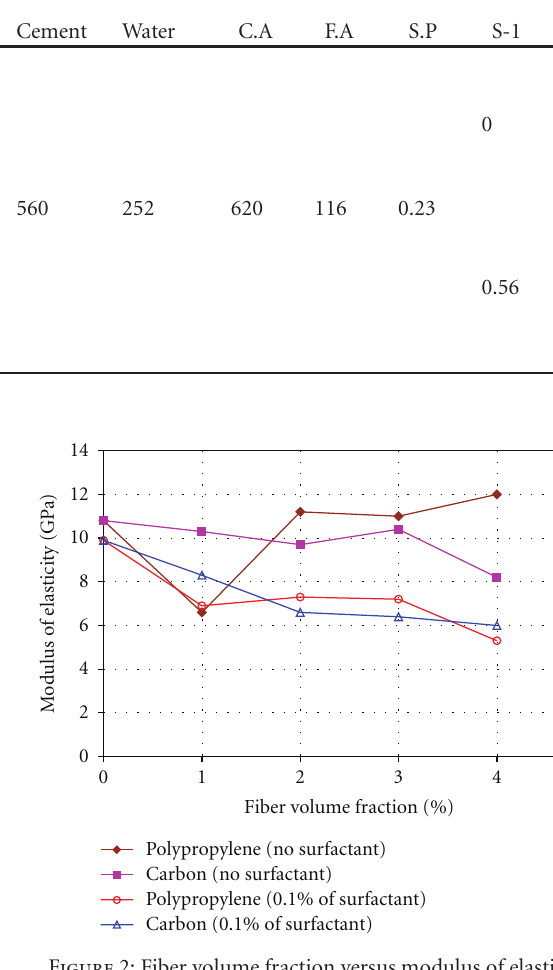
ranged from 12.6 to 17.5 MPa, with axial strain at peak stress varying from 0.0023 to 0.0031 mm/mm.